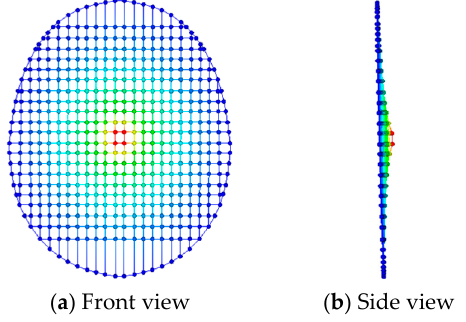
Figure 11. Deformations of the string plane when applying 50N to each